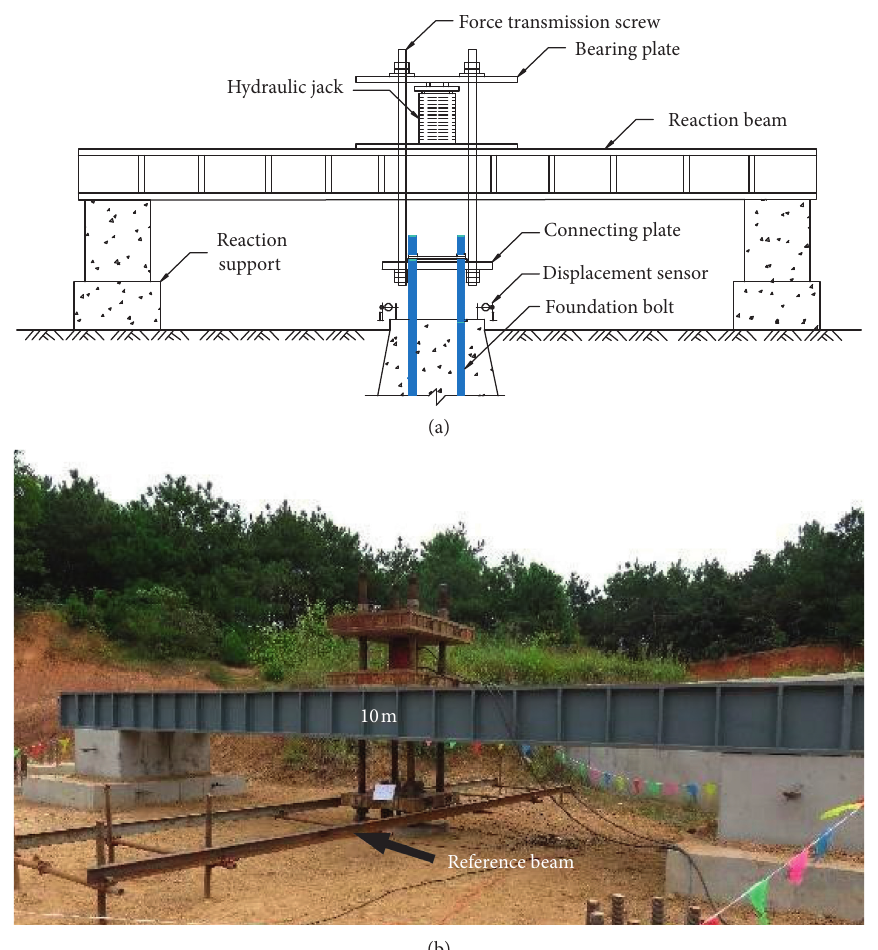
Figure 3: Schematic diagram of the axial uplift loading test: (a) schematic diagram of the loading system; (b) uplift loading test in